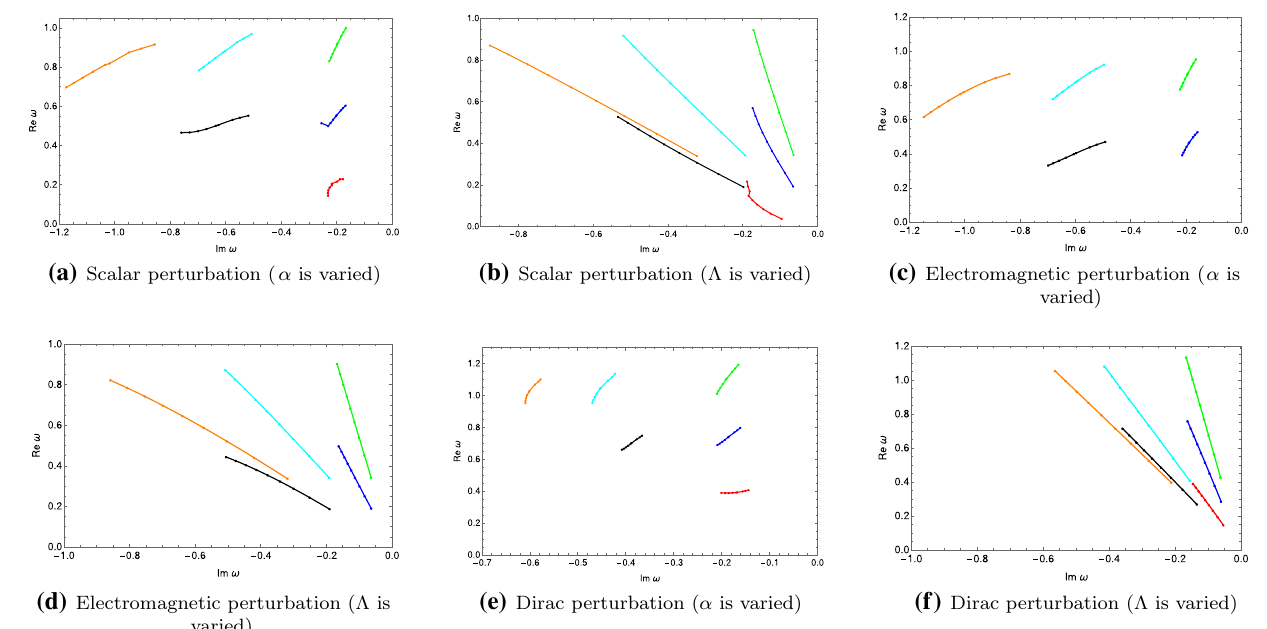
Fig. 3 The figure plots the real part of the quasinormal frequencies vs the imaginary part for different parameters (α,(cid:3)) of the four dimen- sional Gauss–Bonnet de Sitter spacetime, for different types of pertur-